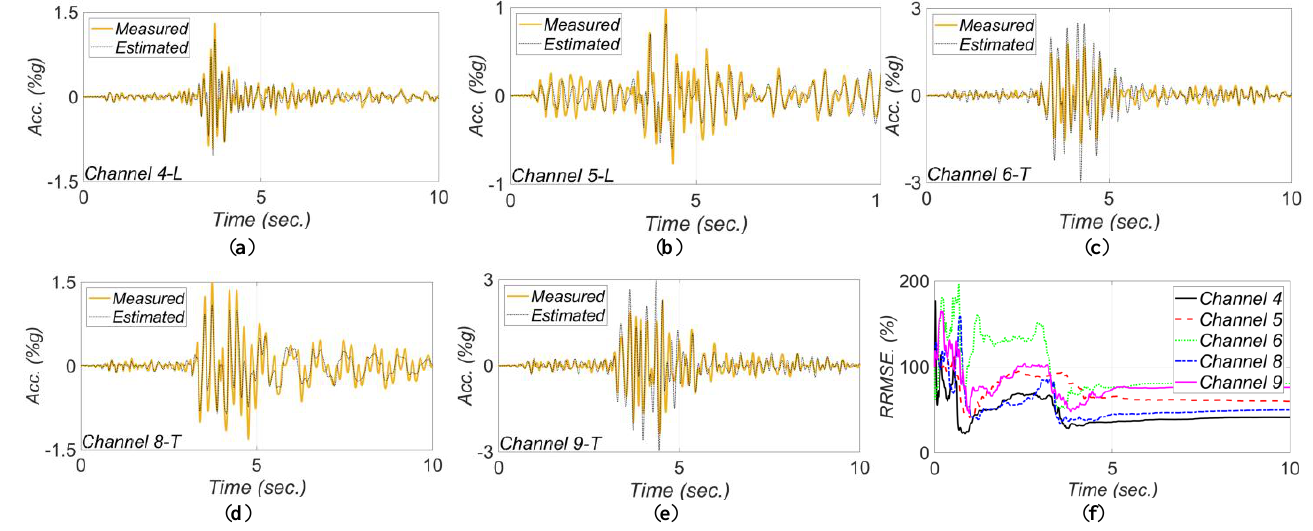
Figure 19. Comparison between measured and estimated (from updated model) responses at different measurement channels for 2013 IslaVista earthquake: ( a ) channel 4, ( b ) channel 5, ( c ) channel 6, ( d ) channel 8, ( e ) channel 9. Part ( f ) is the corresponding RRMSEs.